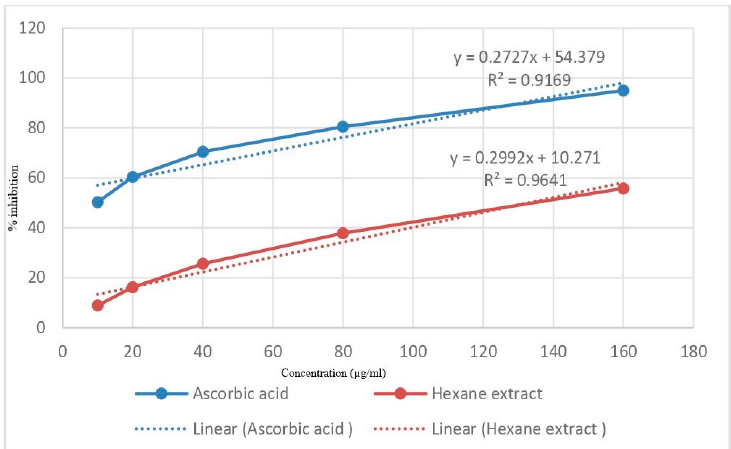
Figure 1. DPPH radical scavenging activity of standard Ascorbic acid and n-hexane extract of M. oleifera